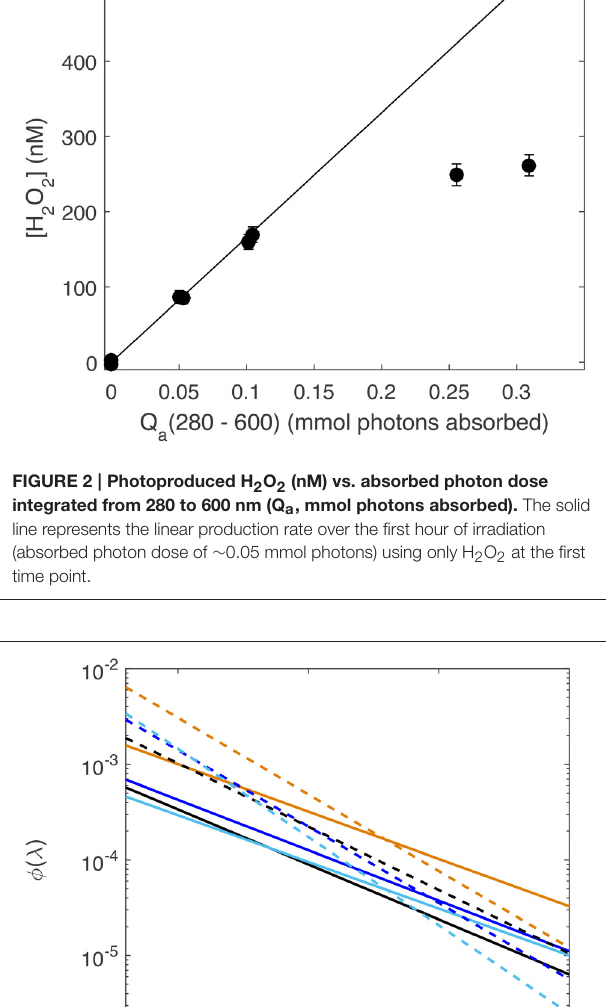
errors (nRMSE) < 8% for all but the untreated Gulf